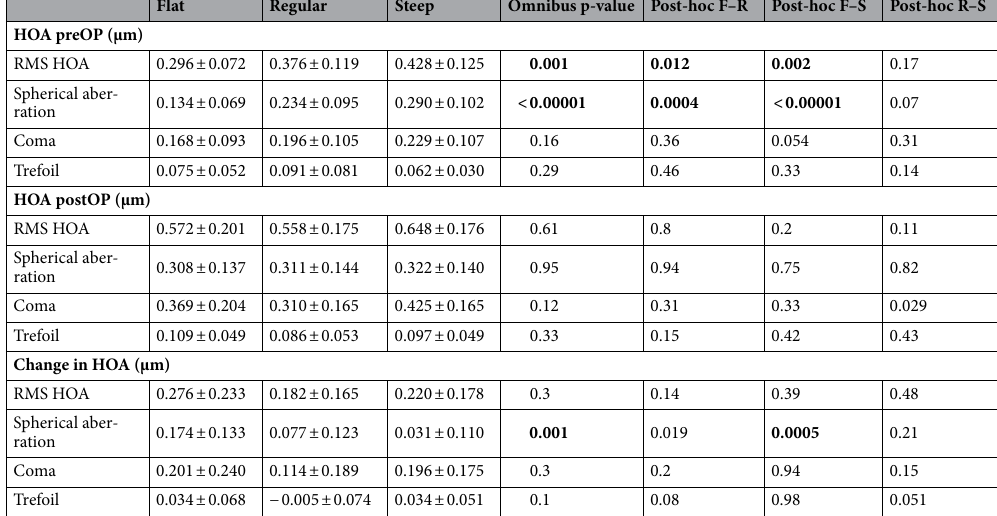
Table 3. Changes in higher-order aberrations related to